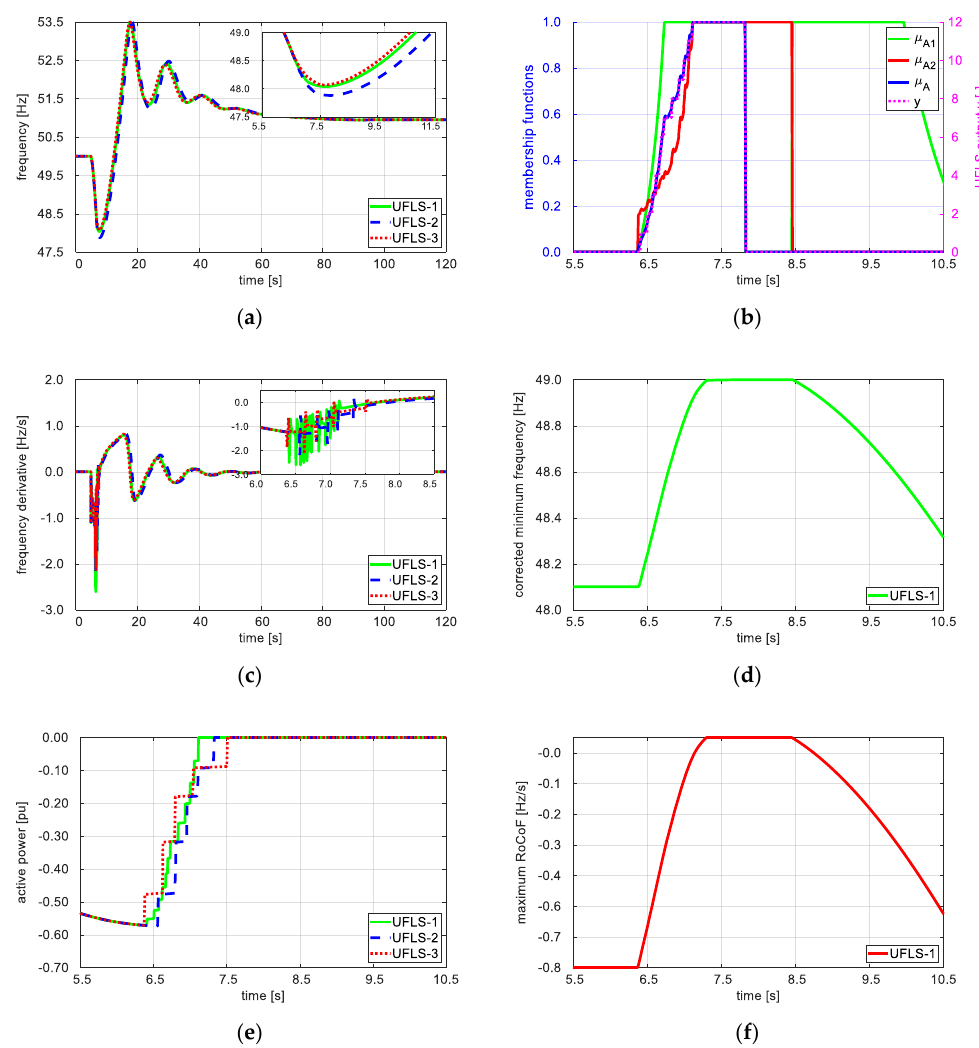
Figure 5. Time variation of selected variables during the unloading process for Case A: ( a ) frequency, ( b ) membership functions and UFLS output y , ( c ) frequency derivative (RoCoF), ( d ) corrected minimum frequency f * min , ( e ) active power disconnected, ( f ) maximum RoCoF f (cid:48)∗ max